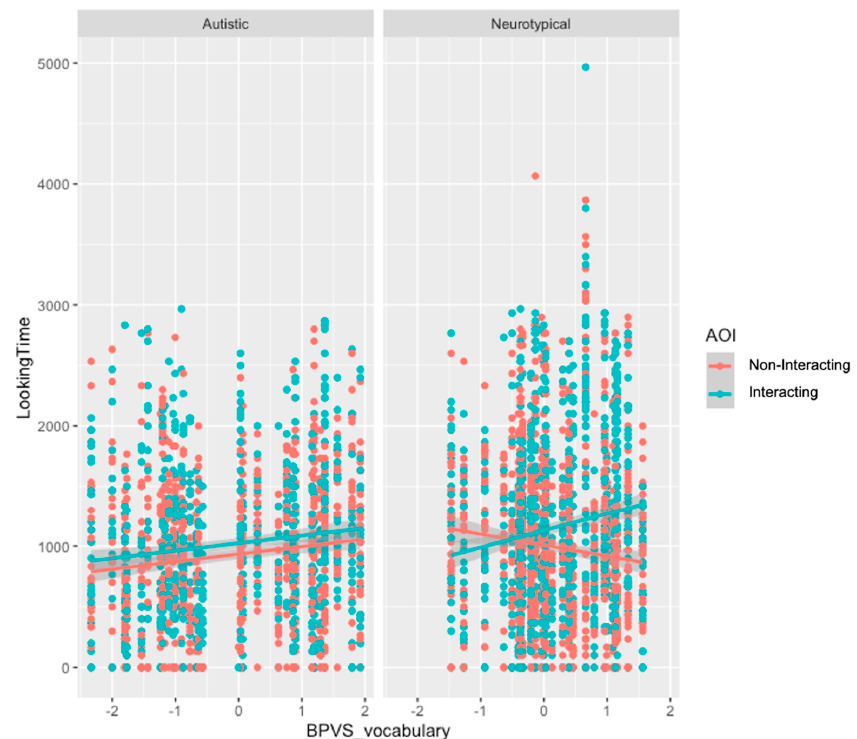
Figure 2. Significant three-way interaction effect from the linear mixed model using whole figure AOIs with raw data points included. Z-scores were used for BPVS scores, and looking times are in milliseconds (ms).